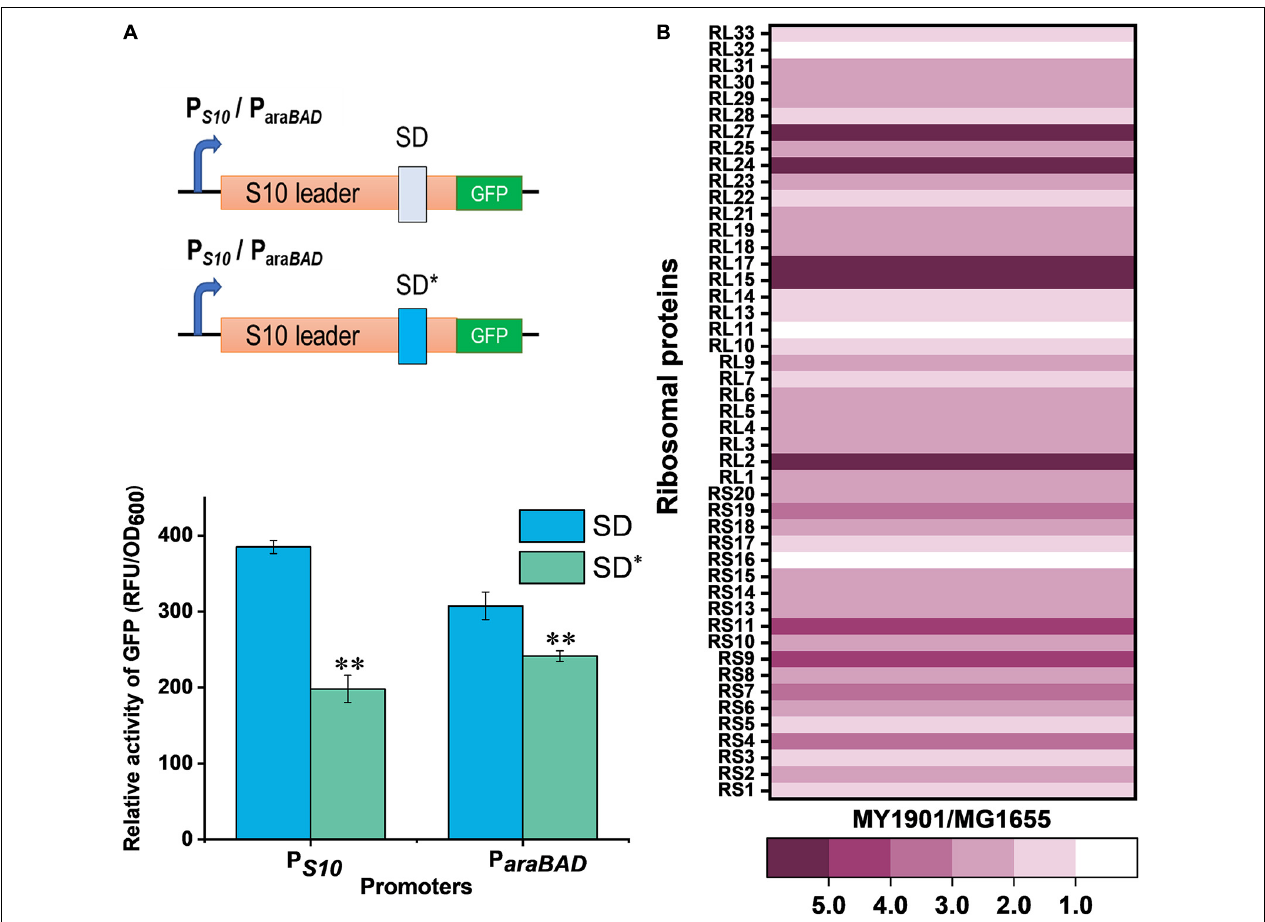
FIGURE 2 | Effects of SRP suppressor on ribosomal protein synthesis. (A) Effects of mutant SD sequence on protein translation. GFP was used as a reporter to measure gene expression. (Top) Graphical representation of GFP expression. P S10 /P araBAD -GFP with wild-type SD and suppressor mutation SD* were introduced into cells. (Bottom) Fluorescence measurement of GFP. Data represent the mean of six independent experiments, and error bars represent the standard deviation of the mean value. Statistical significance compared to wild-type SD sequence using Student’s t -test is indicated as follows: * P < 0.05; ** P < 0.01. (B) Fold changes in the expression of ribosomal proteins in strain MY1901relative to that in strain MG1655 ( Supplementary Data Set 1B ).